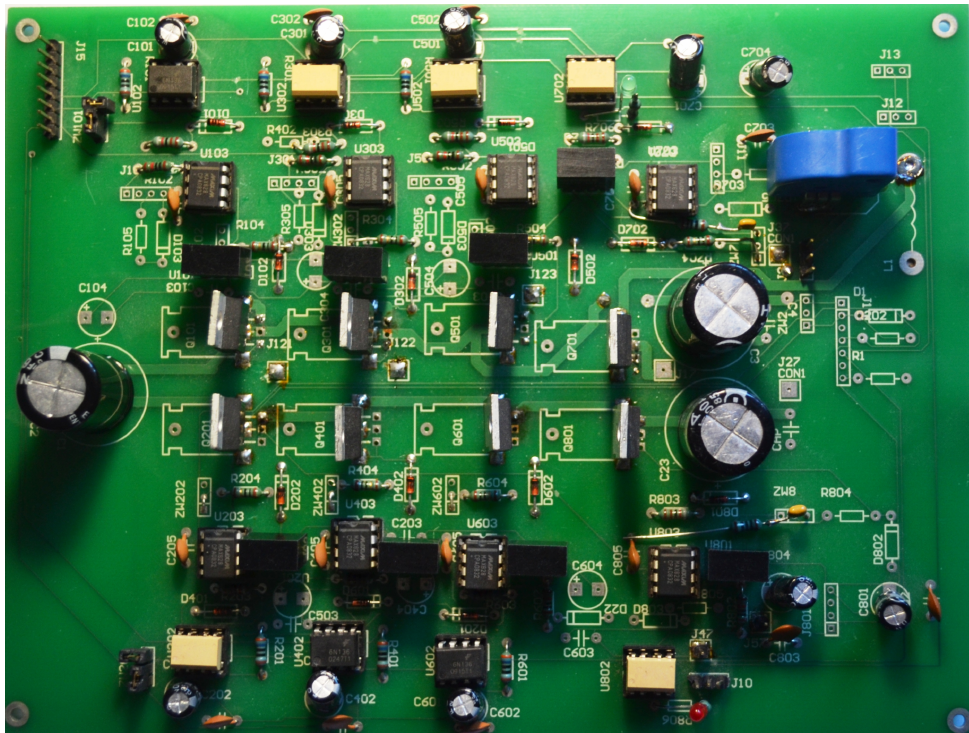
Figure 20. Developed BLDC motor control circuit board without the heat sinks on the